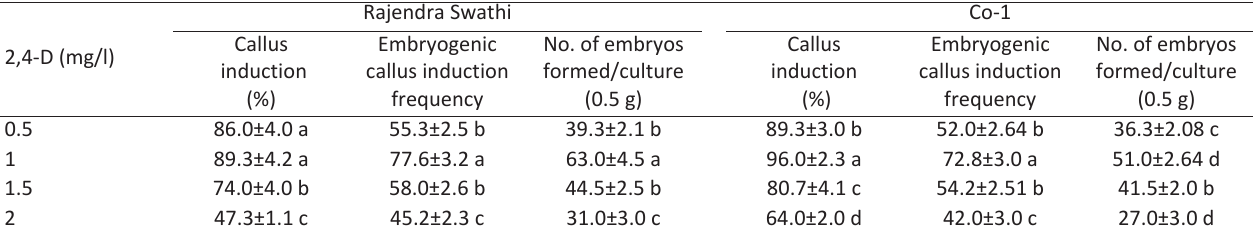
Table 1 - Effect of different concentrations of 2,4-D on callus induction and somatic embryogenesis from hypocotyl explants of ‘Rajendra Swathi’ and ‘Co-1’ varieties of Coriandrum sativum